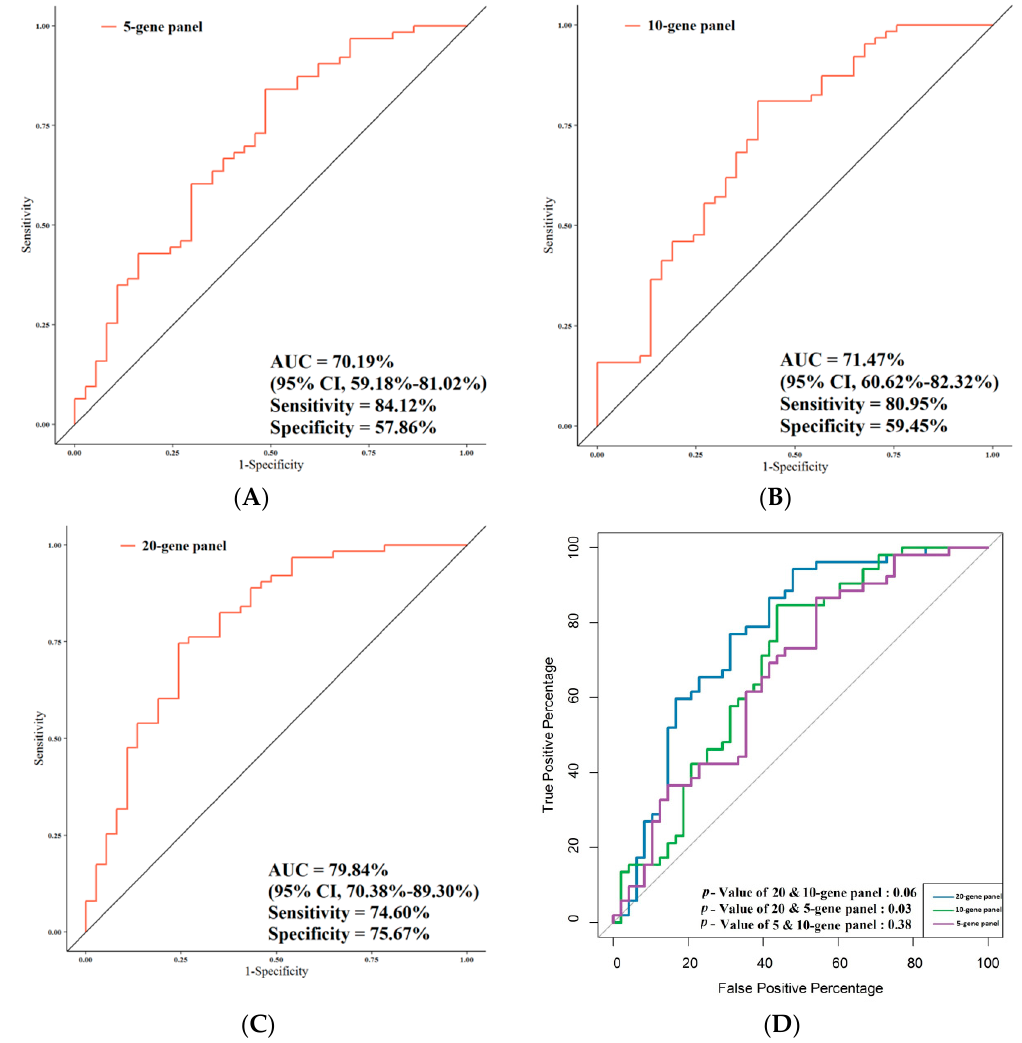
Figure 7. Comparison of the predictive performance by receiver operating characteristic (ROC) curve analysis for lymph node metastasis (LNMs). ( A ) The AUC assessment of the logit( p ) value for the panel of 5 genes. ( B ) The AUC assessment of the logit( p ) value for the panel of 10 genes. ( C ) The AUC assessment of the logit( p ) value for the panel of total genes. ( D ) Comparison of the predictive performance for the panel of 5, 10, and 20 genes.